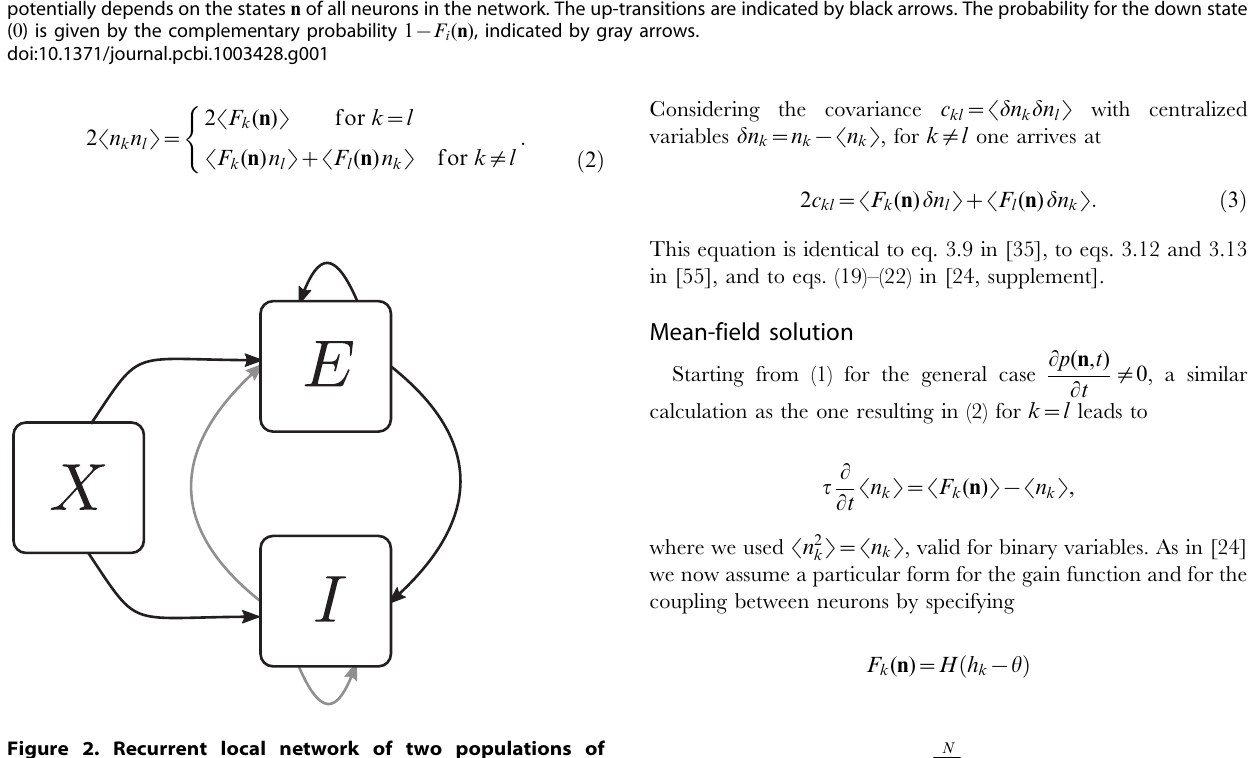
Figure 2. Recurrent local network of two populations of excitatory ( E ) and inhibitory ( I ) neurons driven by a common external population ( X ). The external population X delivers stochastic activity to the local network. The local network is a recurrent Erdo¨s-Re´nyi random network with homogeneous synaptic weights J ab coupling neurons in population b to neurons in population a , for a , b [ f E , I g and same parameters for all neurons. There are N ~ 8192 neurons in both the excitatory and the inhibitory population. The connection probability is p ~ 0 : 2 , and each neuron in population a receives the same number K ~ pN of excitatory and inhibitory synapses. The size N X of the external population determines the amount of shared input received by each pair of cells in the local network. The neurons are modeled as binary units with a hard threshold h